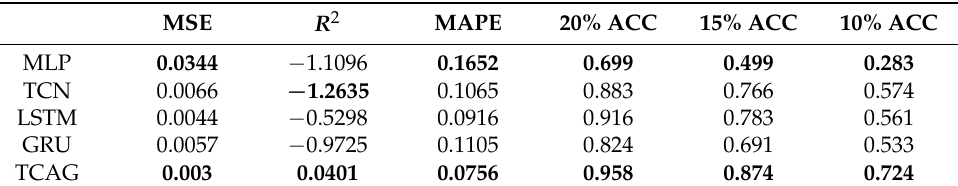
Table 4. Comparison of MLP, TCN, LSTM, GRU, TCAG.